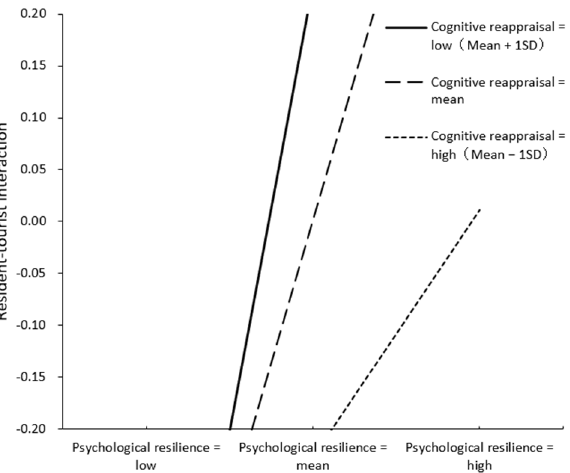
Figure 2. The moderating effect of cognitive reappraisal on psychological resilience and resident– tourist interaction.